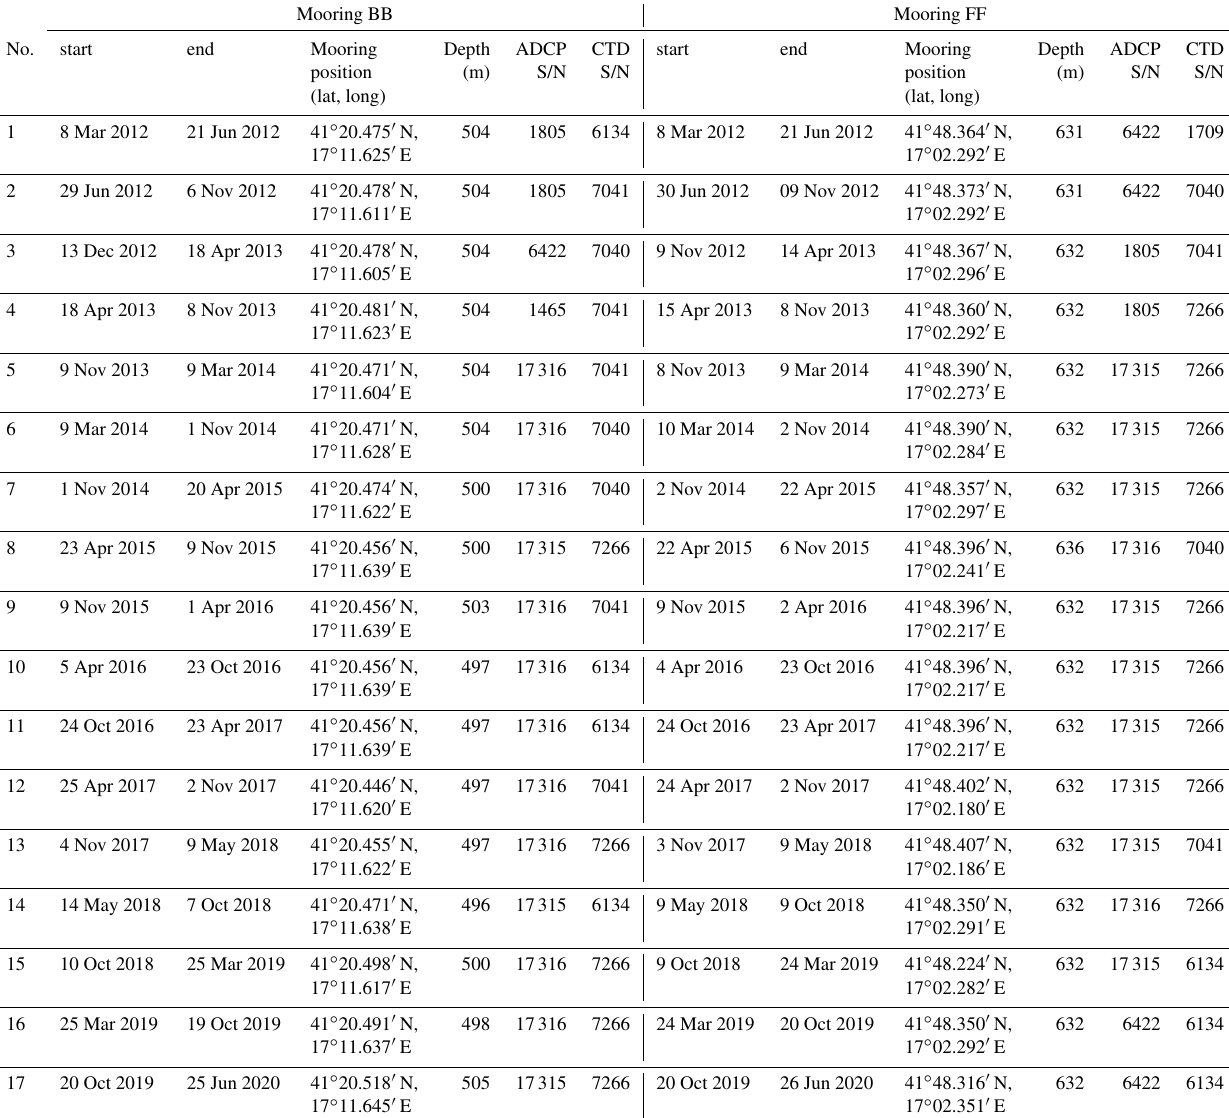
Table 1. Survey details on the two mooring sites. Number of survey (no. 17), start and end of each survey, mooring position, depth of mooring site, and ADCP and CTD serial number (S/N) of instrument used. Mooring BB Mooring FF